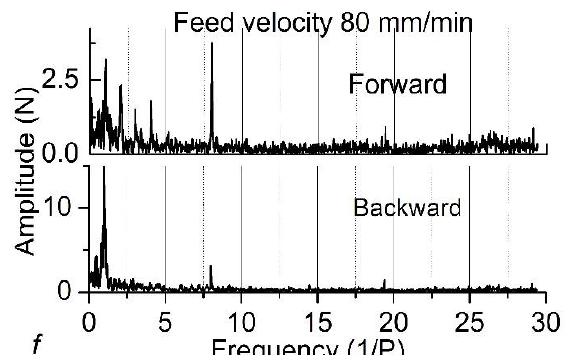
Figure 16. Effects of the feed velocity and direction on the FFT spectrum for FFS. (a) The component amplitudes of the FFS for the nine segments at the forward feed velocity of 560mm/min; (b) The frequency spectrum over the WTDOW at the feed velocity of 560mm/min; (c) The frequency spectrum over the WTDOW at the feed velocity of 400mm/min; (d) The frequency spectrum over the WTDOW at the feed velocity of 280mm/min; (e) The frequency spectrum over the WTDOW at the feed velocity of 200mm/min; (f) The frequency spectrum over the WTDOW at the feed velocity of 80mm/min.